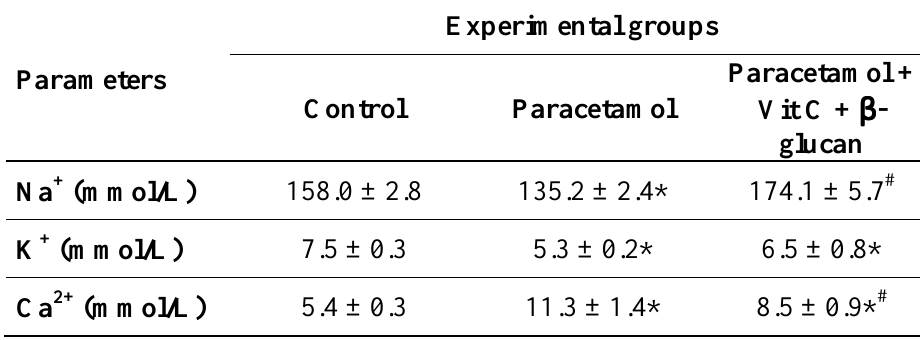
Table 3. Effects of vitamin C and b -glucan on electrolytes in serum of paracetamol-treated